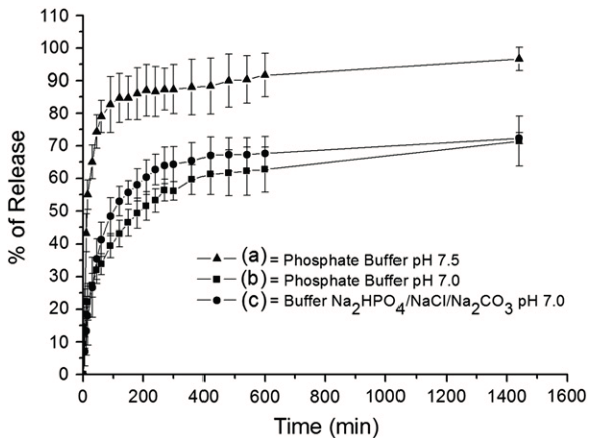
Figure 11. Release curves of DIK from ZnAl–LDH–DIK under different conditions. Reprinted with permission from [74] (Copyright 2011